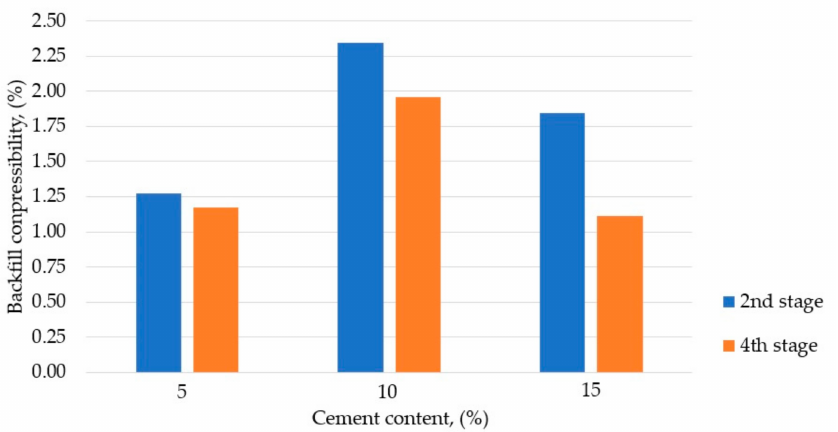
Figure 16. The dependence of the backfill compressibility on the cement content, taking into account the stages of exploitation and filling the strip